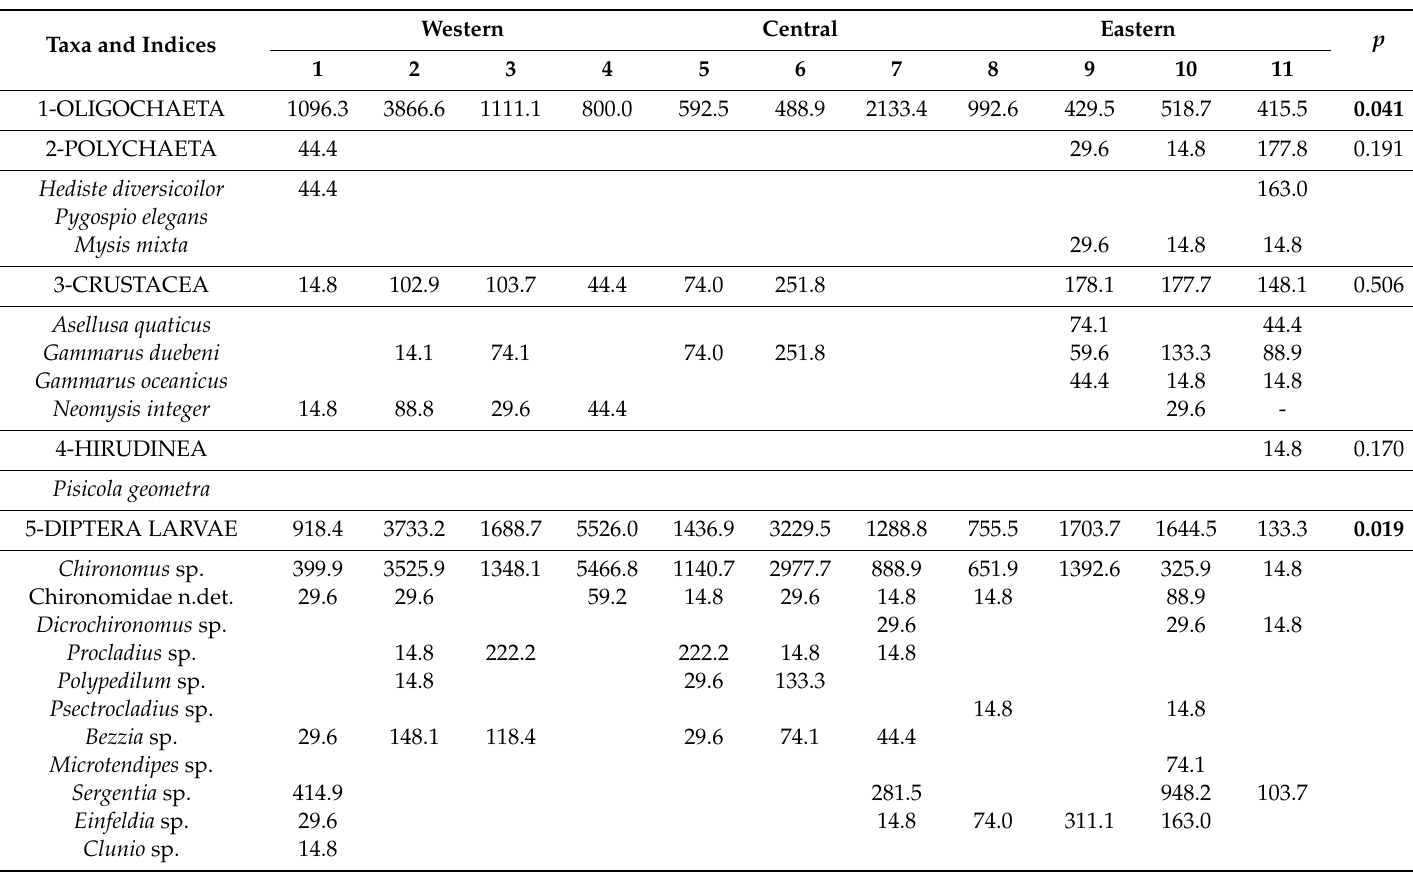
Table 5. Composition of macrozoobenthos (ind · m − 2 ) at the di ff erent sampling sites (1–11) in parts of Lake Łebsko in 2014–2015, and results of one-way ANOVA evaluating di ff erences between the